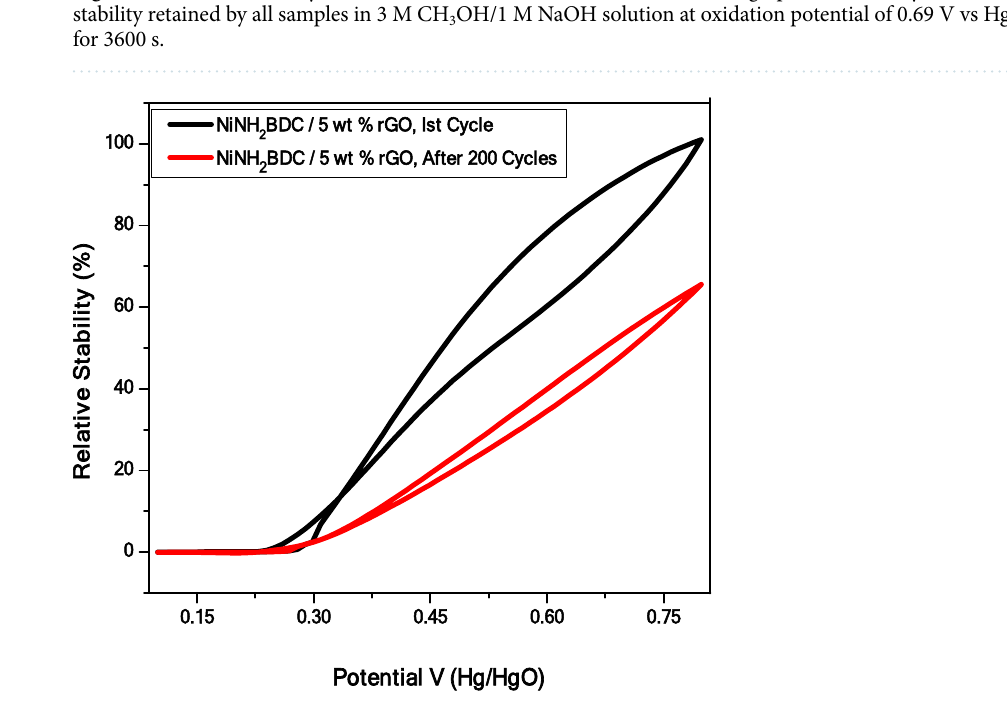
Figure 13. ( a ) The Cyclic stability test of NiNH2BDC MOF/5 wt% reduced graphitic carbon hybrids in 3 M